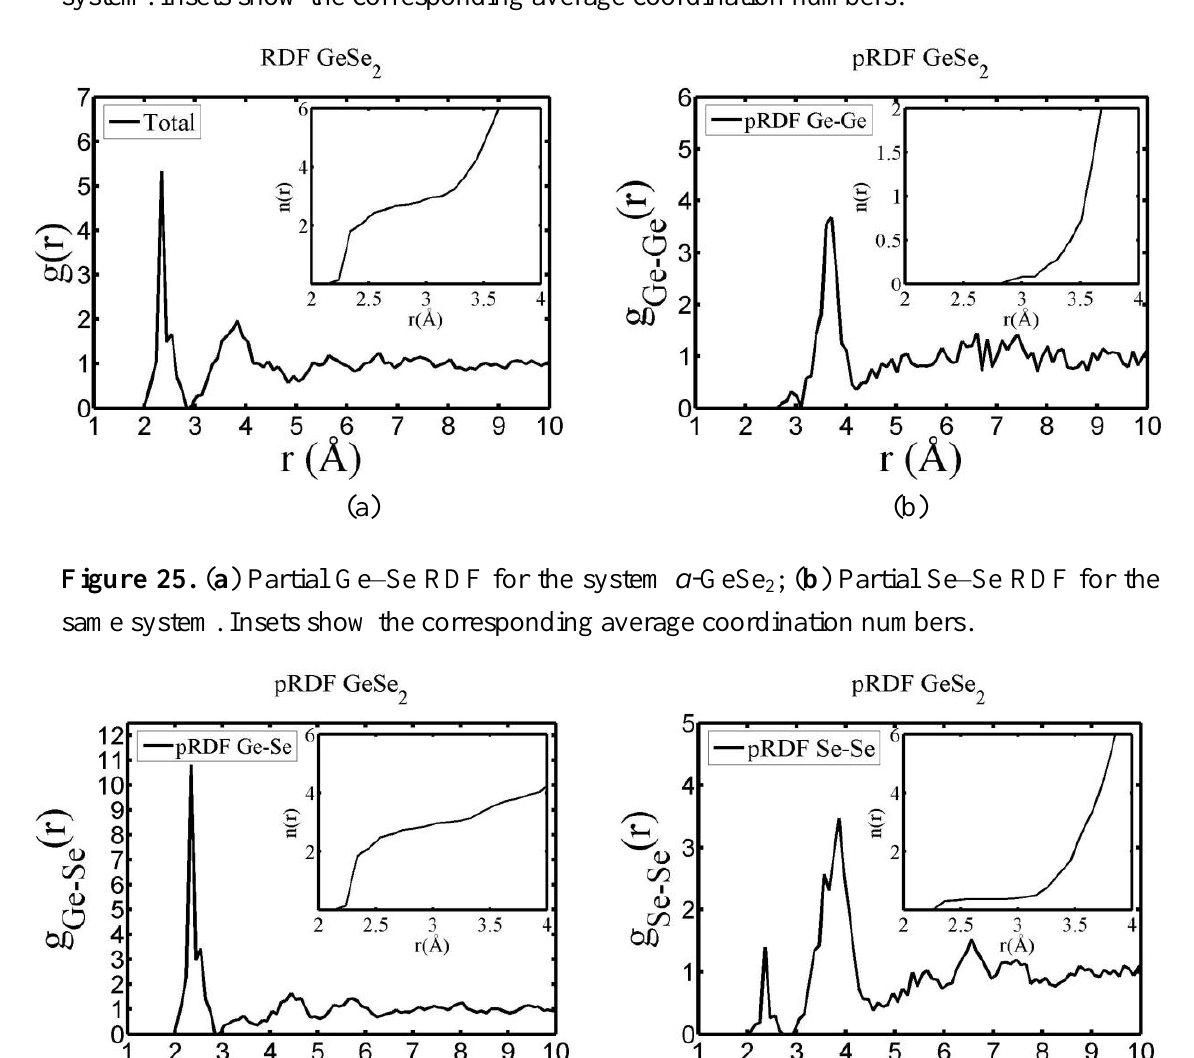
Figure 24. ( a ) Total RDF for the system a -GeSe system. Insets show the corresponding average coordination numbers.